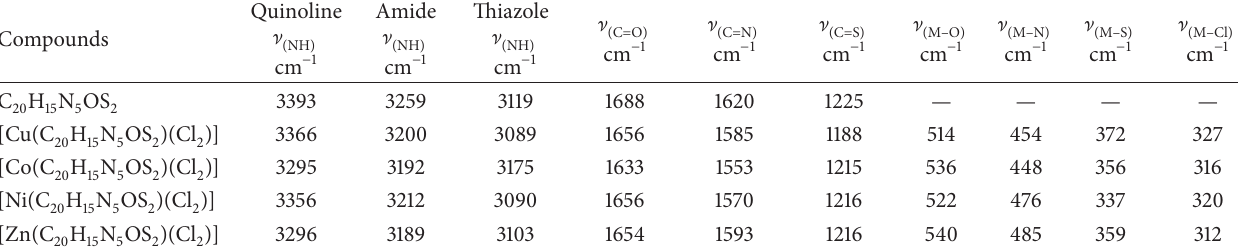
Table 2: IR spectral data of Schiff base ligand (L) and its metal complexes.